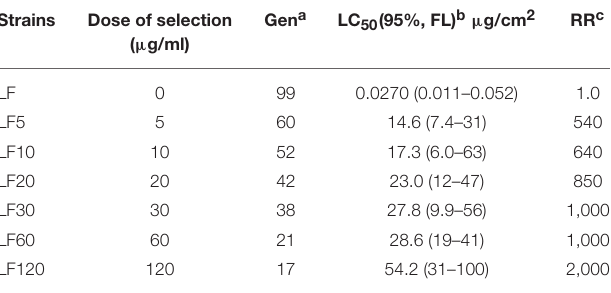
TABLE 1 | Responses to Cry1Ac of the susceptible strain (LF) and six resistant strains (LF5, LF10, LF20, LF30, LF60, and LF120) of H. armigera . Strains Dose of selection ( µ